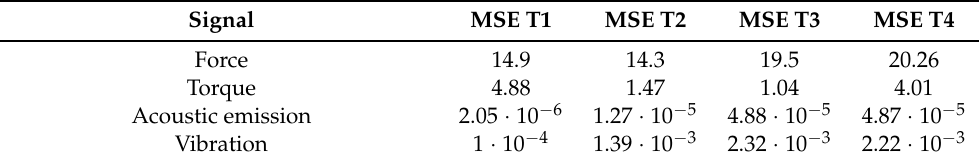
Table 4. Reconstruction performance of all datasets, in terms of mean squared error, for all acquired signals, force, torque, acoustic emission RMS, and